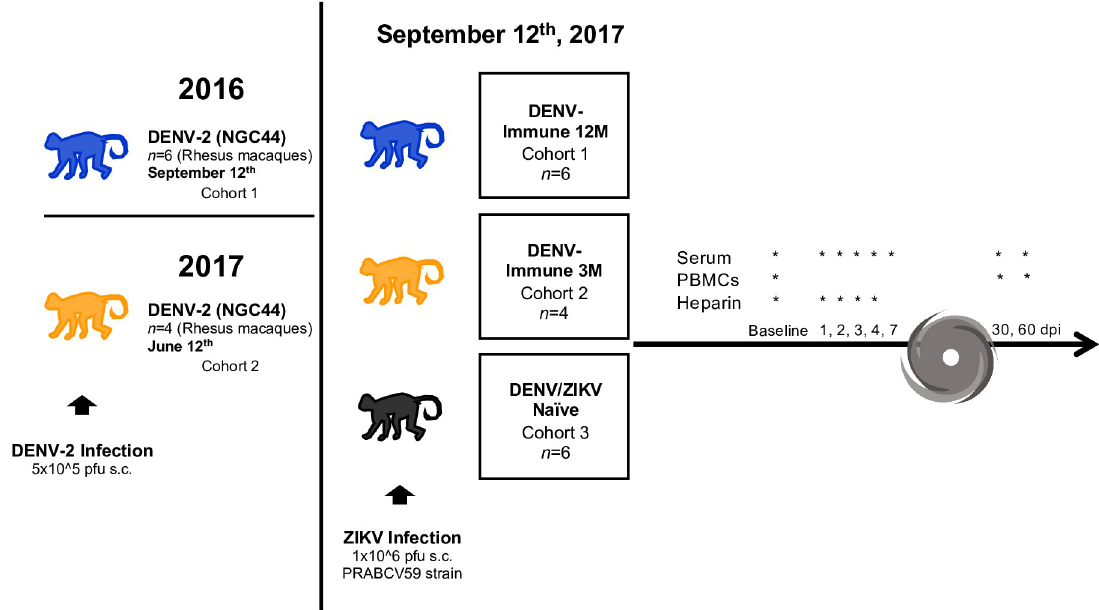
Fig 1. Experimental design of ZIKV infection in DENV-immune and na ï ve macaques. Two cohorts of rhesus macaques ( Macaca mulatta ) were exposed to DENV-2 (5 x 10 5 pfu s.c.) at different timepoints. Both cohorts were exposed to ZIKV strain PRABCV59 (1 x 10 6 pfu s.c.) on September 12 th , 2017, along with a third cohort composed of ZIKV and DENV na ï ve animals (n = 6). ZIKV infection was performed 12 months after DENV infection for cohort 1 (n = 6), and 3 months after DENV infection for cohort 2 (n = 4). Serum was collected at baseline and days 1 through 7 post ZIKV infection (p.i.). Sample collection was interrupted by Hurricane Marı´a’s impact, and resumed on day 30 p.i. PBMCs could only be obtained on baseline, day 30 and 60 p.i., while heparinized whole blood was collected on baseline and days 1 through 3 p.i. Additionally, urine was collected on baseline and days 2, 4 and 6 p.i.